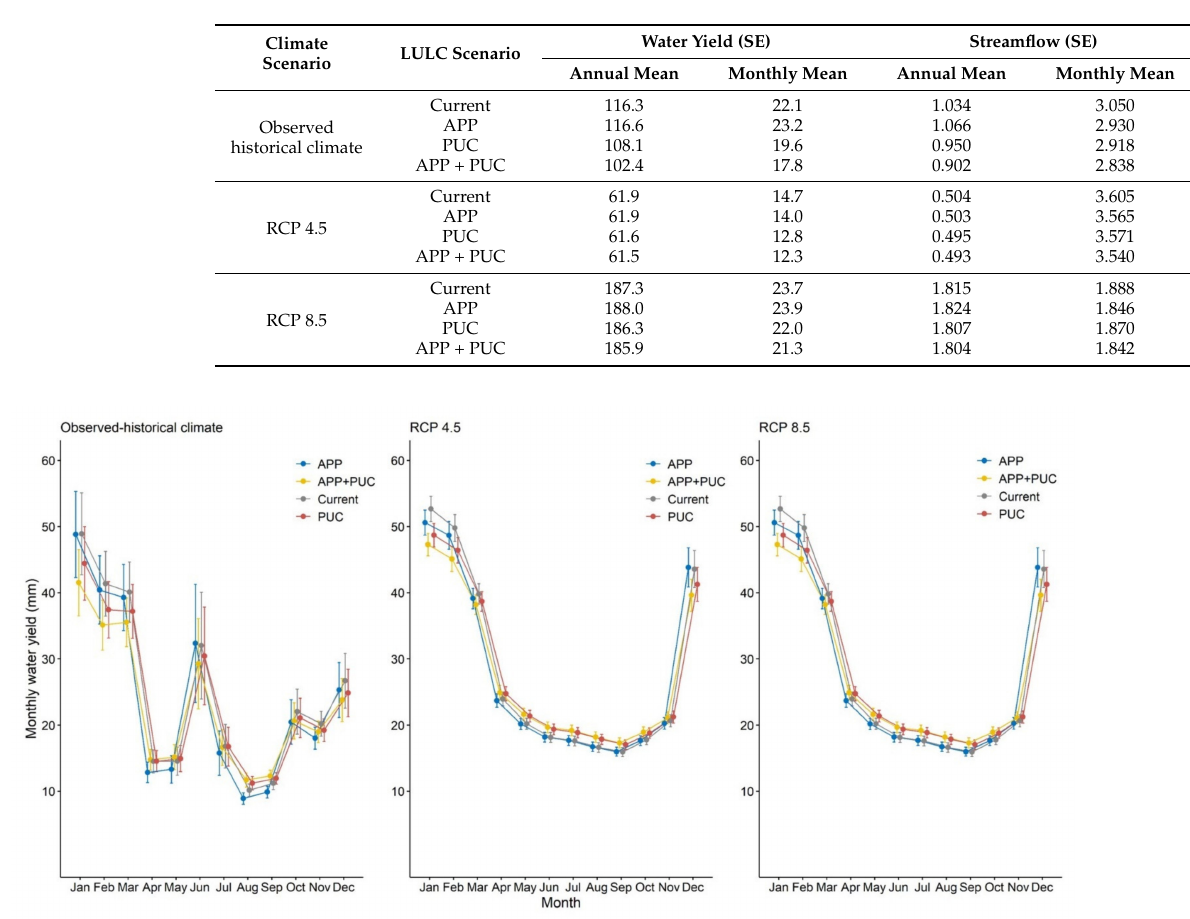
Table 6. Standard error (SE) values for the annual mean and monthly mean water yield and stream- flow for each climate and LULC scenario. APP = riparian restoration; PUC = focal conservation; APP + PUC = combined solution.